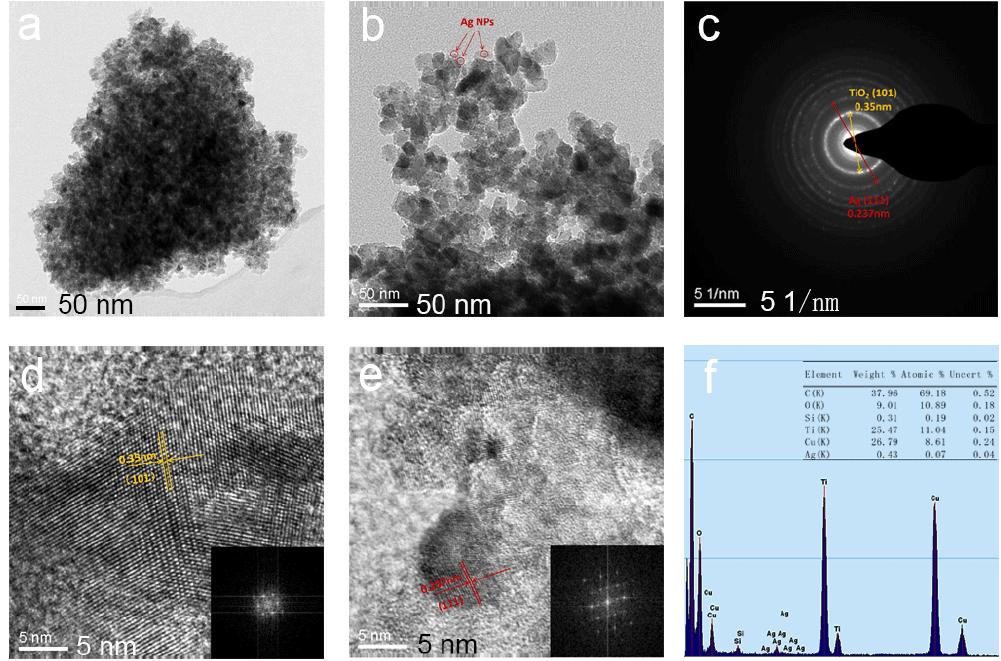
Figure 2. Transmission electron microscopy with EDS capabilities (TEM) image of the pure TiO 2 NPs ( a ) and Ag@TiO 2 NPs-0.5 ( b ); selected area electron diffraction (SAED) image of Ag@TiO 2 NPs-0.5 ( c ); high-resolution electron microscopy (HRTEM) image taken from TiO 2 NPs ( d ) and the corresponding fast Fourier transform (FFT) mode; HRTEM image taken from Ag NPs ( e ) and the corresponding FFT mode; EDS of Ag@TiO 2 NPs-0.5 ( f ).